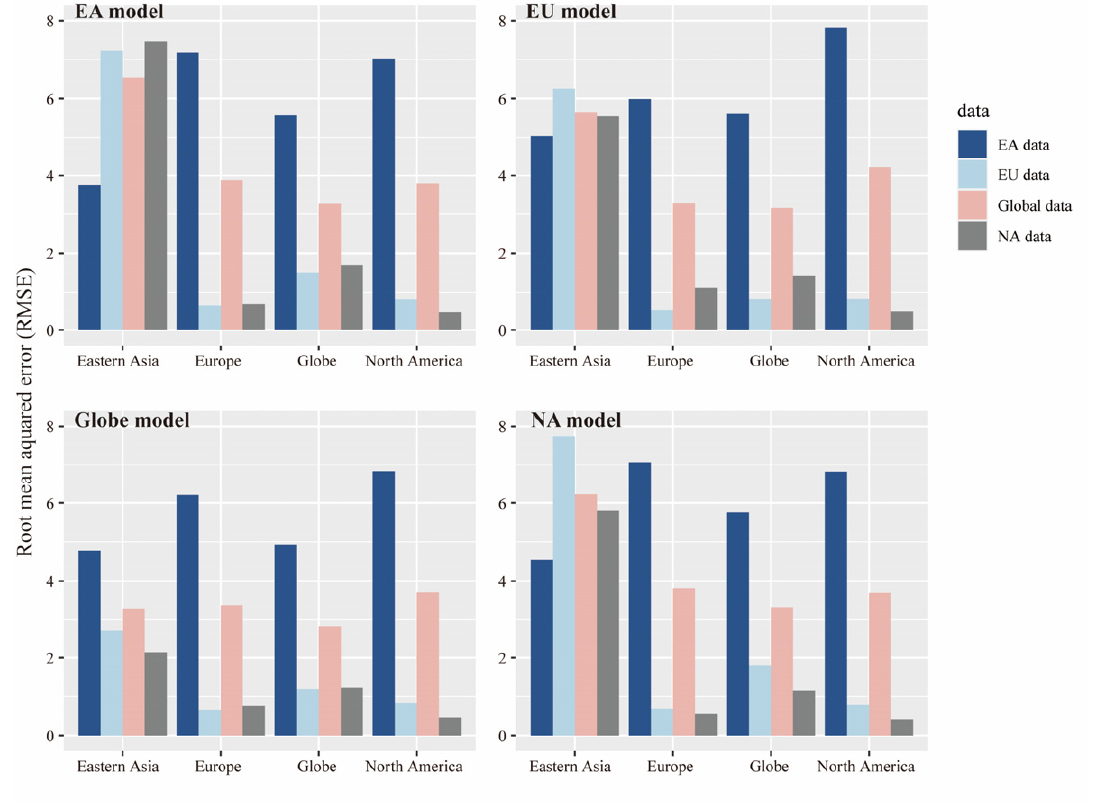
Figure 4. Root mean squared errors of the four integrated models were assessed when they were used to predict the subgenus Cerasus species richness at the global scale and in eastern Asia (EA), North America (NA), and Europe (EU) (color bars). Each of the four models was calibrated separately using eastern Asian data, European data, North American data, and Global data ( x ‐ axis). Table 4. Stepwise regression models for each group of variables and integrated model for two re ‐ gions in eastern Asia.